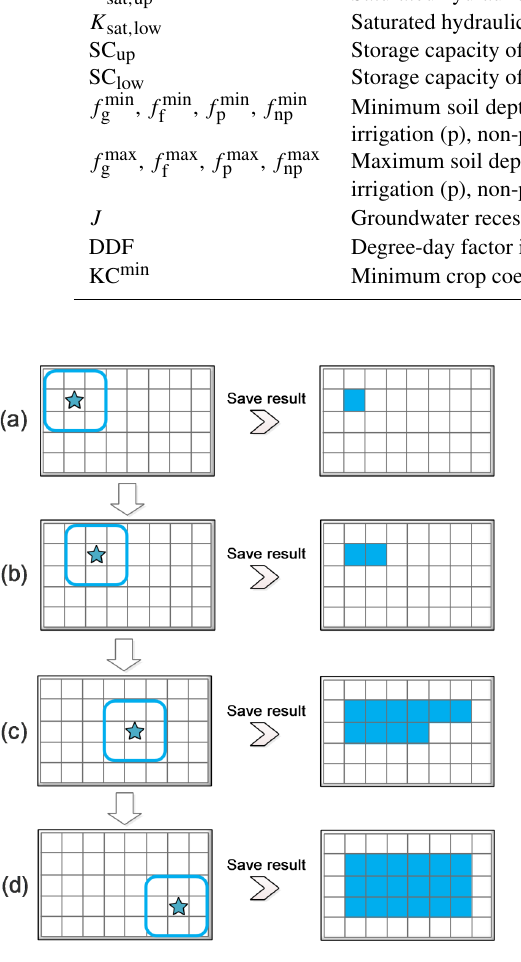
Figure 7. Demonstration of EnKF 3D scheme, accounting for the spatially correlated errors. For a centre grid cell, the state and obser- vation matrices contain all TWS-related components of the neigh- bouring grid cells and the centre grid cell (left). The graphic demon- strates the case of one pixel (0.5 ◦ ) correlation distance. The bound- ary stretches farther for larger correlation distance. The covariance matrices P e and R are computed based on the data from these grid cells. Then, the EnKF is applied and the states of the centre grid cell are updated (right). The procedure is repeated through all grid